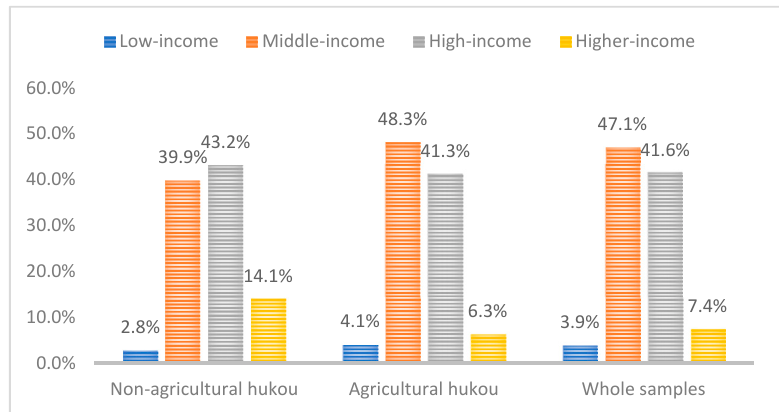
Figure 3. Proportion of different income levels of various samples.